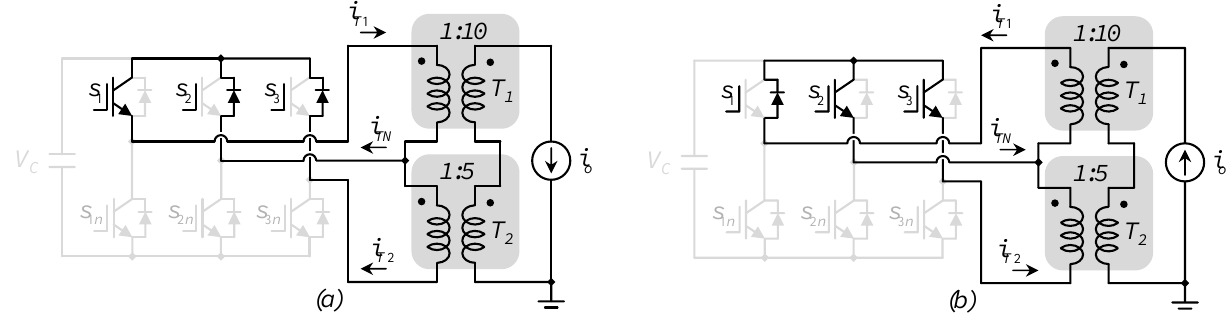
when the load current is positive and (b) when the load current is negative.